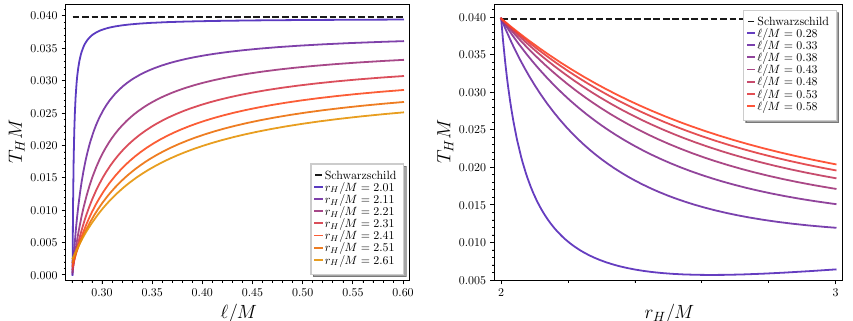
Figure 3. Left panel: Hawking temperature of hairy black holes depending on hairy parameter (cid:96) for different values of the horizon radius r H . Notice the low temperature for (cid:96) 2 Me − 2 . Right panel: → Hawking temperature of hairy black holes depending on horizon radius r H for different values of the T Shw for any (cid:96) . In both cases, the decoupling hairy parameter (cid:96) . When r H 2 M , the temperature T H → → parameter α was eliminated using Equation (14) and the radius r H = 2 M corresponds to the extreme